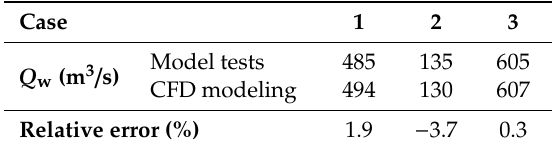
Figure 7. CFD results of Q w in Case 3: simultaneous discharges from two surface and bottom gates. Table 1. Results of Q w , comparisons between physical tests and CFD.